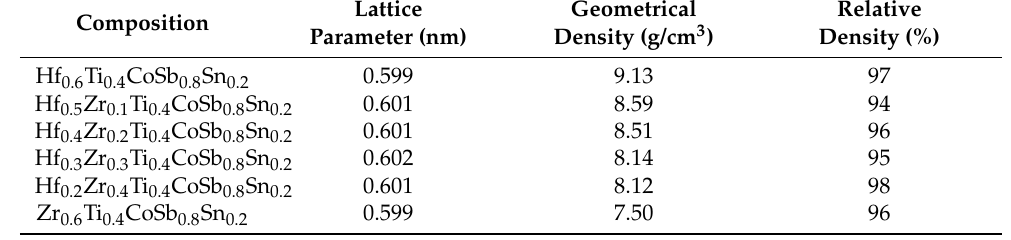
Table 1. Lattice parameter, geometrical density and relative density based on the crystallographic